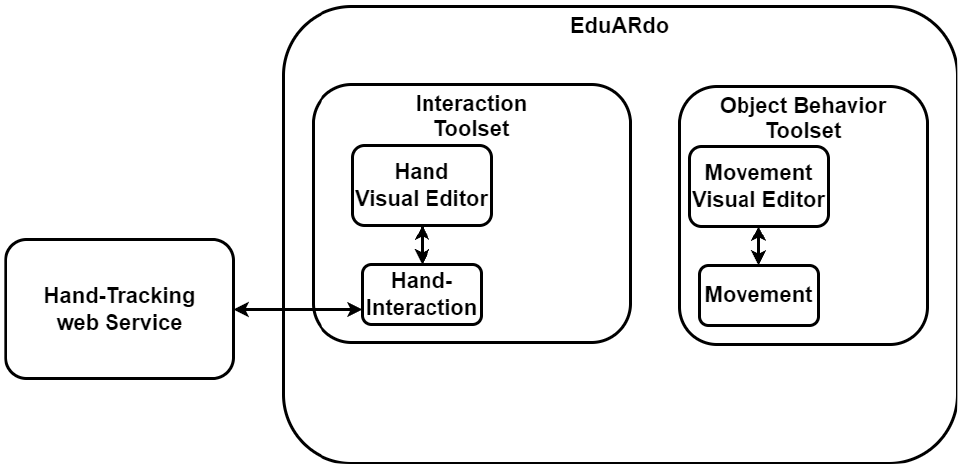
Figure 1. EduARdo Architecture.